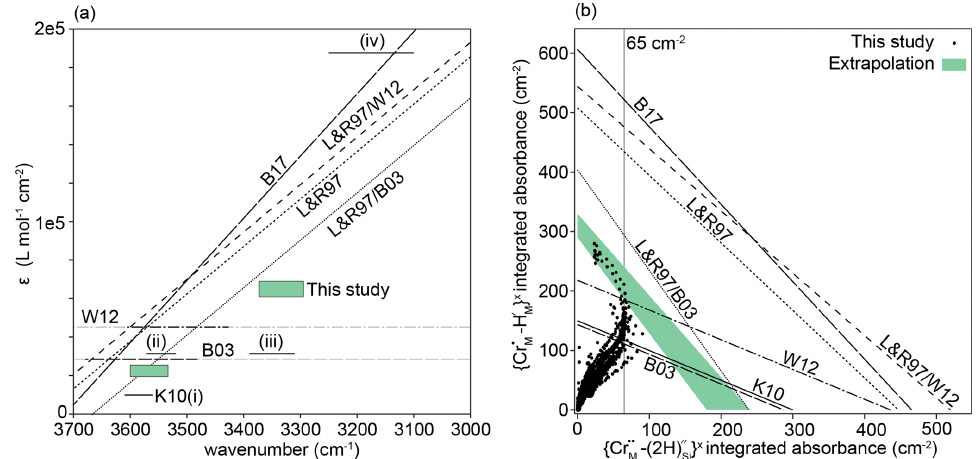
(cid:113)(cid:113) − Figure 14. (a) Published absorption coefficients. K10 (solid lines, i–iv) are from Kovács et al. (2010), for defects: (i) ( 4H ) × , (ii) { Ti M Si (cid:113) } × , (iii) { Sc − H (cid:48) } × , (iv) ( 2H ) × ( 2H ) (cid:48)(cid:48) . B03 is the wavenumber-independent absorption coefficient from Bell et al. (2003), and W12 is M M M Si the same from Withers et al. (2012). The black sections of these lines represent the wavenumbers of bands in their analysed samples; grey sections are extrapolations. L&R97 is the wavenumber-dependent relationship from Libowitzky and Rossman (1997), L&R97/W12 is the L&R97 relationship pinned to the W12 data at 3600cm − 1 , and L&R97/B03 is the L&R97 relationship pinned to the B03 data at 3550cm − 1 . B17 is the wavenumber-dependent relationship from Blanchard et al. (2017). The green boxes represent absorption coefficients extracted (cid:113)(cid:113) (cid:113) − ( 2H ) (cid:48)(cid:48) } × , the upper right box for { Cr − H (cid:48) } × . (b) The integrated total absorbance from our data – the lower left box is for { Cr (cid:113) (cid:113)(cid:113) M M M Si − H (cid:48) } × versus that for { Cr − ( 2H ) (cid:48)(cid:48) } × , from this study (points) and using the absorption coefficients in Table 3, assuming for { Cr (cid:113) (cid:113)(cid:113) M M M Si − H (cid:48) } × and 55.4wtppm H { Cr − ( 2H ) (cid:48)(cid:48) } × , joined by straight lines (see text 27.7wtppm H 2 O associated with { Cr 2 O associated with M M M Si for details). The green band represents our best estimation of an extrapolation of the upper limb of the boomerang-shaped trend to the